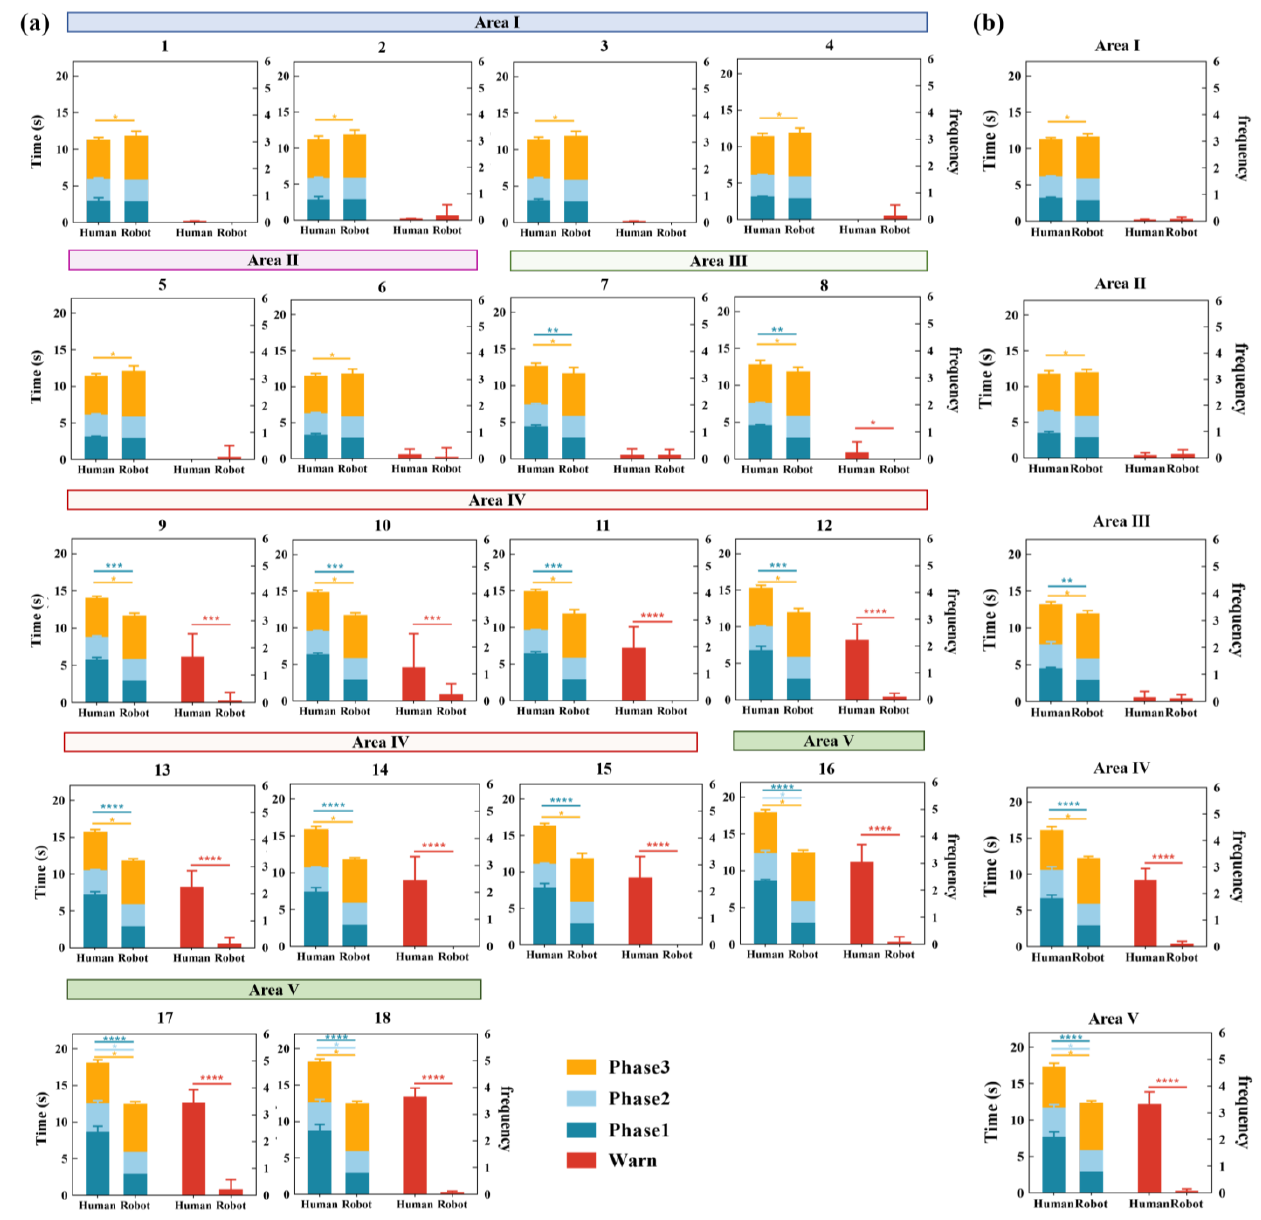
Figure 6. ( a ) The left Y -axis corresponds to the mean ± SD of task completion time to the human operator or HRC when the target ball is located at the first to eighteenth grasping point, respectively. The left bar chart shows the mean ± SD of task completion time taken by each phase of the human operator. The right Y -axis corresponds to the mean ± SD of warning frequency to the human operator or HRC when the target ball is located at the first to the eighteenth grasping point, respectively. ( b ) The left Y -axis corresponds to the mean ± SD of task completion time to the human operator or HRC of each area, respectively. The left bar chart shows the mean ± SD of task completion time taken by each phase of the human operator. The right Y -axis corresponds to the mean ± SD of warning frequency to the human operator or HRC of each area, respectively. * denotes p < 0.05, ** denotes p < 0.01, *** denotes p < 0.001, and **** denotes p <